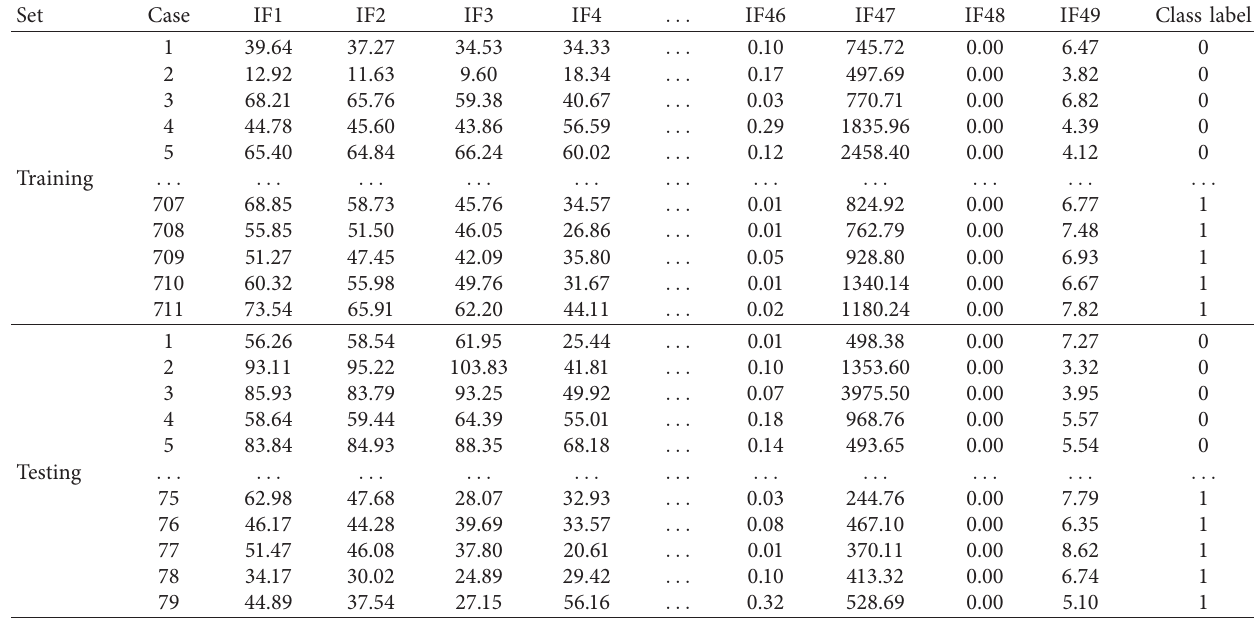
Figure 7: ROI extraction for images containing nonlocalized spall objects: (a) one object and (b) multiple objects. Table 1: Demonstration of the collected